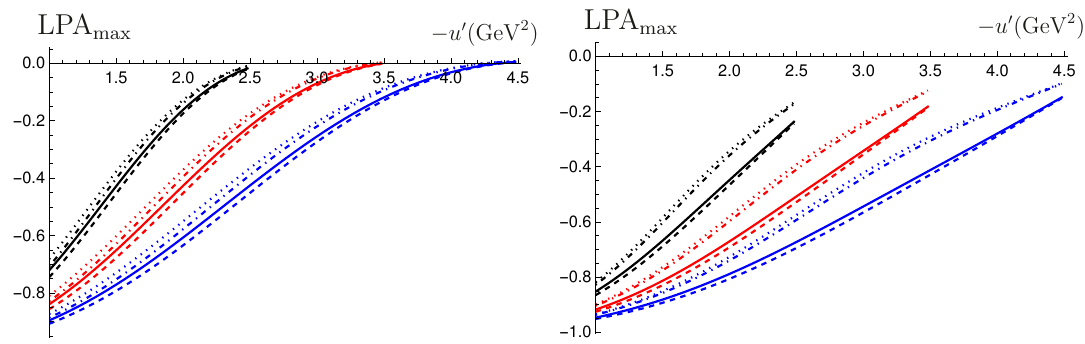
Figure 28 . The LPA at the fully-differential level for π + ( π − ) is shown as a function of ( − u 0 ) on the left (right) for different values of M 2 . The black, red and blue curves correspond to γπ = 3 , 4 , 5 GeV 2 respectively, and S = 20000 GeV 2 . The dashed (non-dashed) lines correspond M 2 γN γπ to holographic (asymptotic) DA, while the dotted (non-dotted) lines correspond to the standard (valence) scenario.